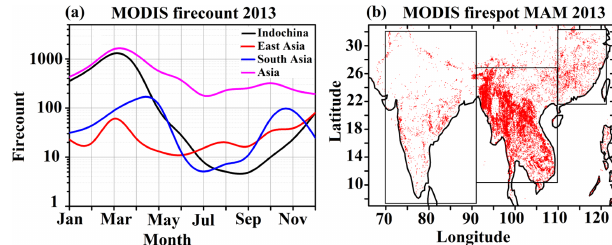
Figure 1. (a) Monthly mean distribution of MODIS fire counts averaged over Indochina (91–107 ◦ E, 10–27 ◦ N), East Asia (108– 123 ◦ E, 22–32 ◦ N), South Asia (70–90 ◦ E, 8–32 ◦ N) and Asia (60– 130 ◦ E, 10 ◦ S–50 ◦ N). (b) Spatial distribution of fire spots over South Asia, Indochina and East Asia averaged for spring 2013. Boxes in (b) indicate the boundaries of South Asia, Indochina and East